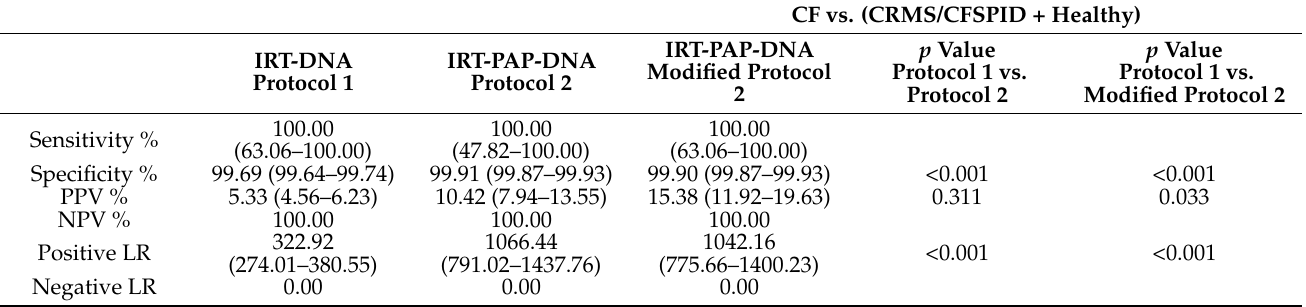
Table 2. Diagnostic performances of two newborn screening algorithms (estimated value and confidence interval between